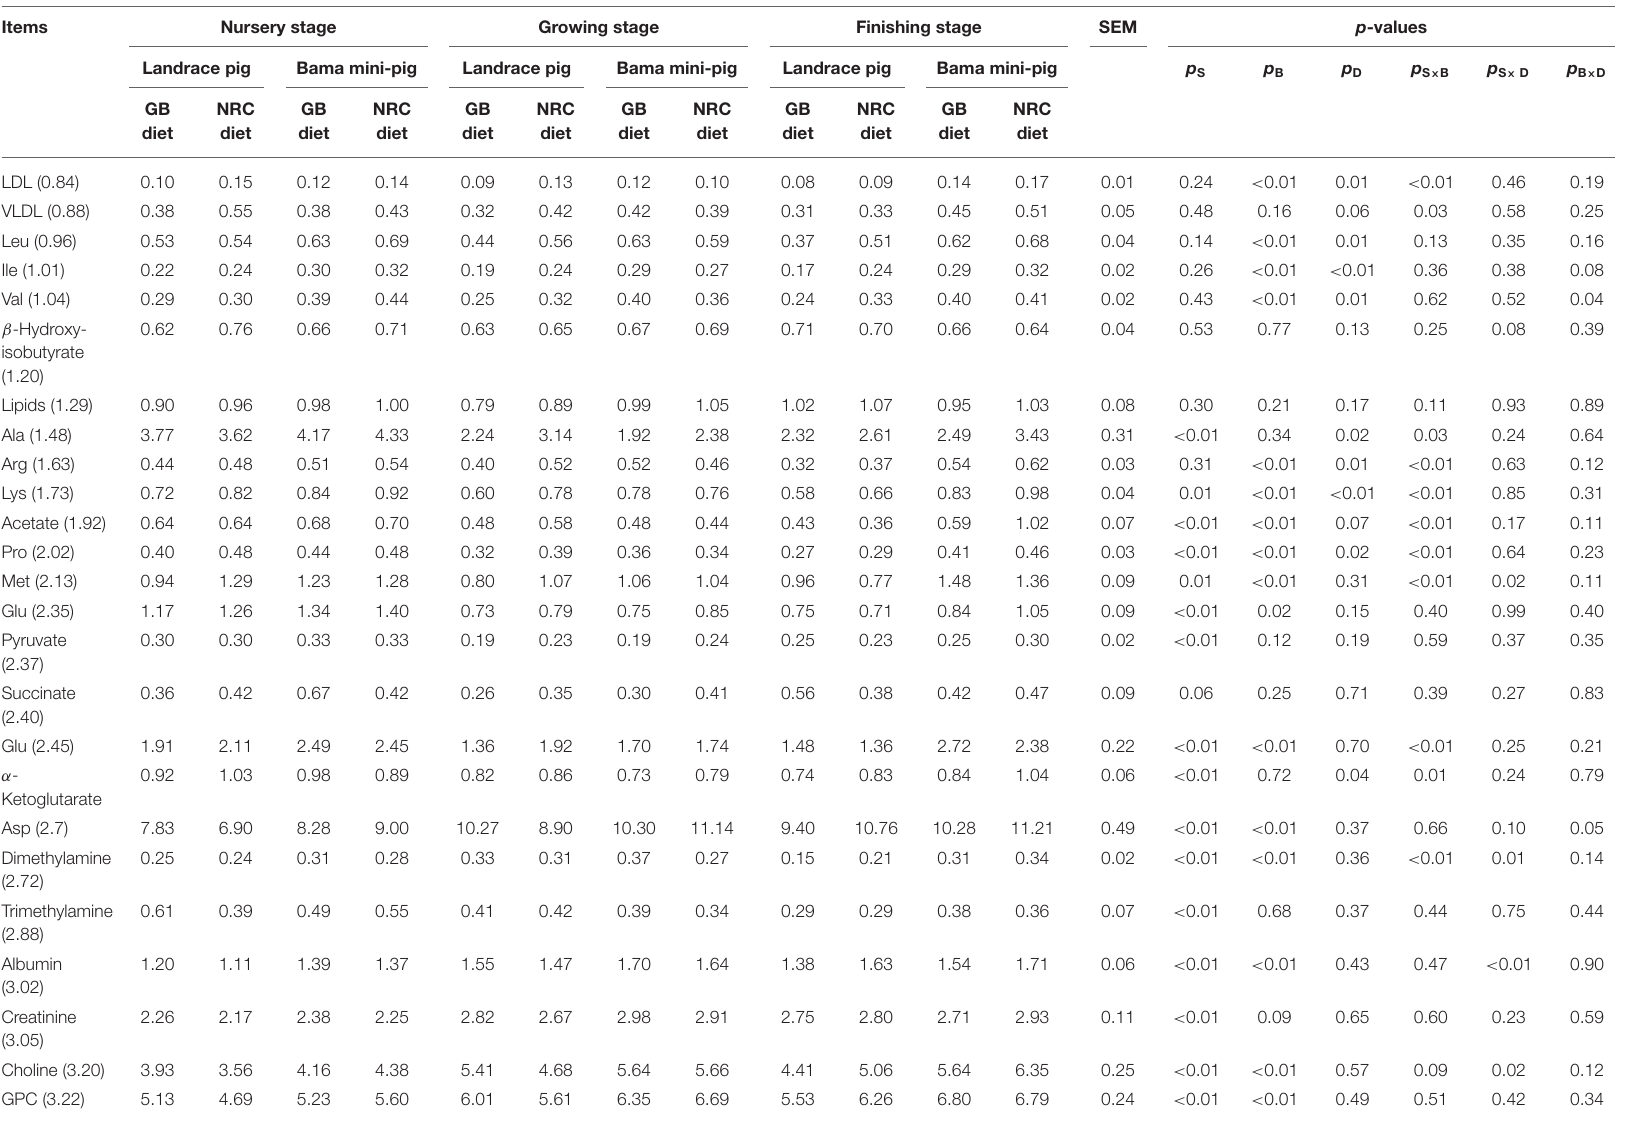
TABLE 5 | Metabolome of psoas major muscle of pigs. Items Nursery stage Growing stage Finishing stage SEM p -values Landrace pig Bama